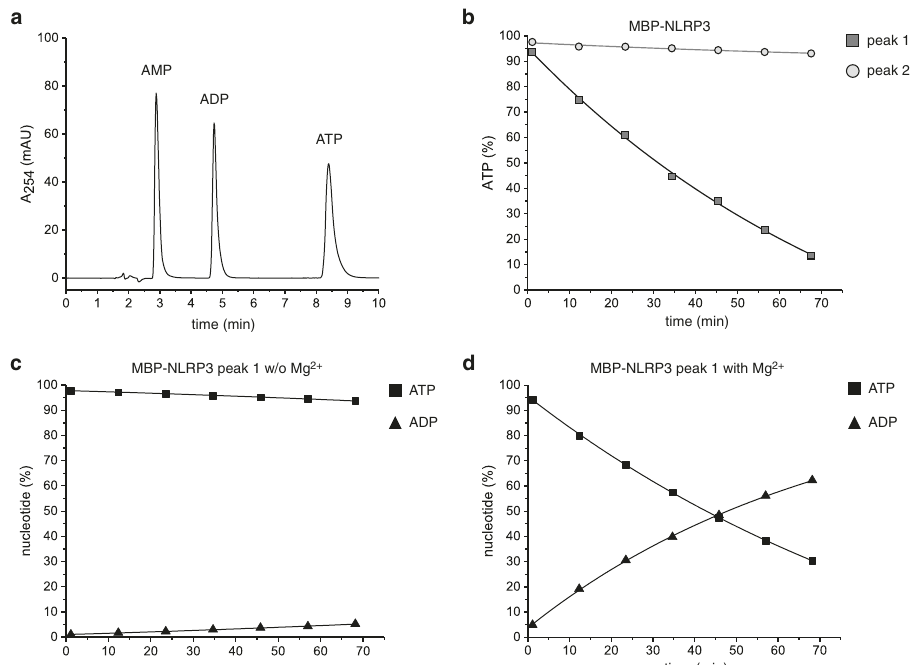
Fig. 2 ATP-hydrolysis activity of NLRP3 determined by reverse-phase HPLC. a Separation of adenosine nucleotides by HPLC on a RP-18 column. Nucleotides elute at about 3 mL (AMP), 4.5 mL (ADP) and 8.5 mL (ATP). b MBP-NLRP3 peak 1 or peak 2 (3 µ M) were incubated at 25 °C for 68 min in the presence of 5 mM MgCl 2 and 100 µ M ATP. The amount of AMP, ADP and ATP was determined in 10 min intervals using RP-HPLC. The eluted peaks were evaluated by integration and the total integral adjusted to 100%. The relative ATP concentration is shown on the y-axis and the time on the x-axis (min). Shown is one representative measurement of n > 5 biologically independent experiments. c The hydrolysis activity of MBP-NLRP3 peak 1 depends on MgCl 2 . MBP-NLRP3 peak 1 (3 µ M) was incubated at 25 °C for 68 min in the presence of 100 µ M ATP, but in the absence of MgCl 2 . Shown is one representative experiment of n = 2 independent experiments. d ATP is hydrolyzed by NLRP3 peak 1 to ADP. MBP-NLRP3 peak 1 at 3 µ M concentration was incubated at 25 °C for 68 min in the presence of 5 mM MgCl 2 and 100 µ M ATP. The relative amount of nucleotide is shown for ATP and ADP. Shown is one representative measurement of n > 5 biologically independent